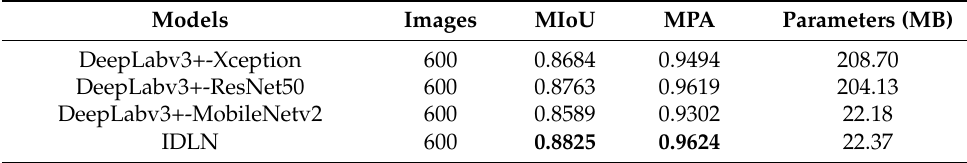
Table 5. Performance of DeepLabv3+ models versus different